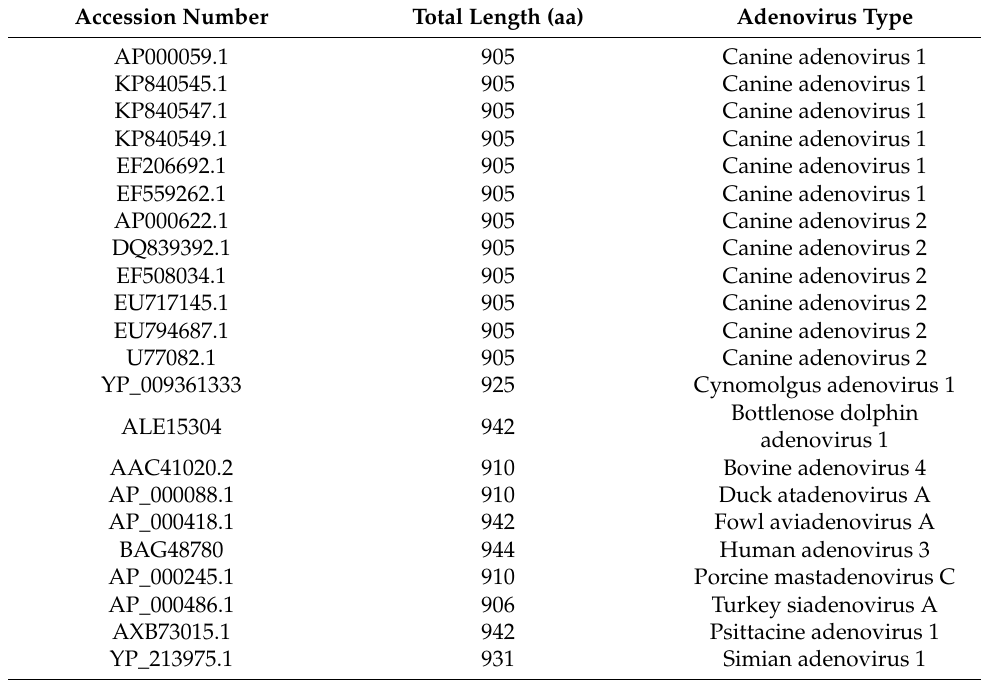
Table 2. Hexon sequences cited in this